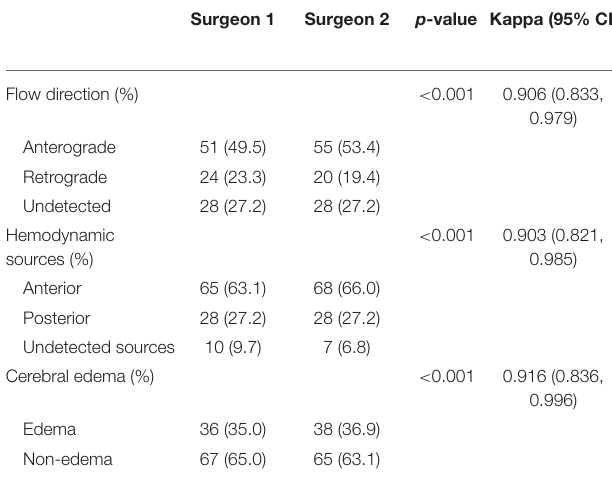
TABLE 3 | The hemodynamic features of recipient vessels involved with postoperative cerebral edema.